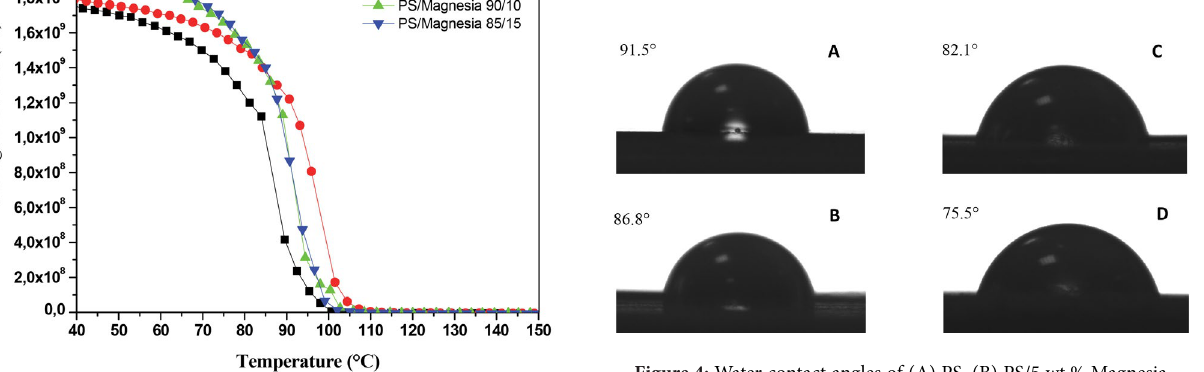
Figure 4: Water contact angles of (A) PS, (B) PS/5 wt.% Magnesia reinforced composite, (C) PS/10 wt.% Magnesia reinforced com- posite, and (D) PS/15 wt.% Magnesia reinforced